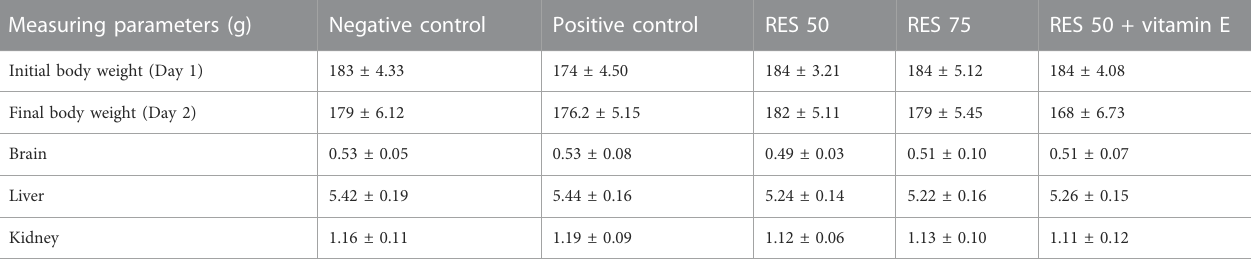
TABLE 2 Effect of RES on the body and organs weight in scopolamine-injected rats. Measuring parameters